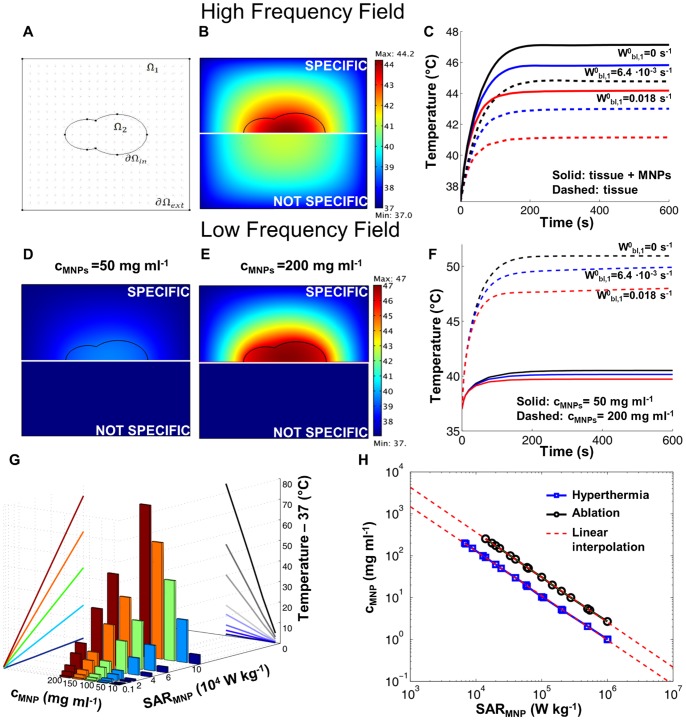
Computational modeling of the temperature field within a biological tissue. 
(A) Computational domain showing the tumor tissue (Ω2) surrounded by the healthy tissue (Ω1). (B) Temperature field at equilibrium for a uniform distribution of SPIOs in Ω 2 (SARf = 900 W g−1) and non specific tissue heating in Ω1Ω2 (SARf = 450 W g−1) (blood perfusion  = 0.018 s−1). Bottom half-panels refer to non specific heating alone (cMNP = 0). (C) Temperature increase with time in the center of Ω2 for different blood perfusion levels in Ω1. Solid lines refers to specific heating (magnetic nanoparticles distributed in Ω2 and dashed lines refers to non specific heating alone. (D, E) Temperature field at equilibrium for a uniform distribution of SPIOs in Ω2 at two different concentrations (50 and 200 mg ml−1). Bottom half-panels refer to non specific heating alone (cMNP = 0). (F) Temperature increase with time in the center of Ω2 for different blood perfusion levels in Ω1. Solid lines and dashed lines refer to 50 and 200 mg ml−1 of SPIOs, respectively. (G) Maximum absolute temperaturereached in the tumor center for different nanoparticle concentrations, cMNP and specific absorption rates, SARMNP. (H) Isotemperature linesfor tissue hyperthermia (Ttissue = 42°C) and thermal ablation (Ttissue = 50°C) drawn as a function of the nanoparticle concentration cMNP and specific absorption rate SARMNP.